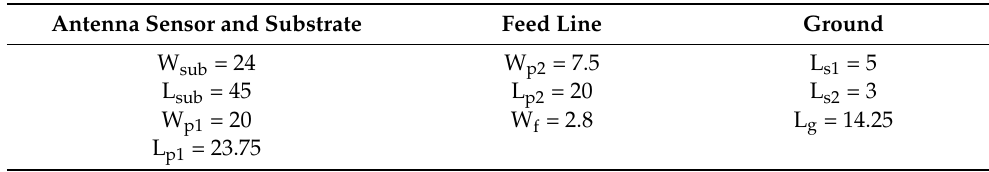
Table 1. The optimized dimensions of the proposed antenna sensor (all dimensions in